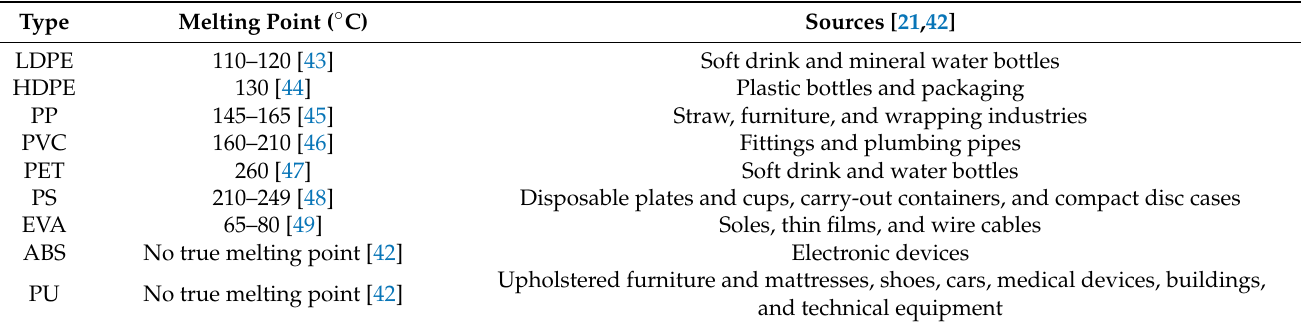
Table 2. Melting point and main sources of waste